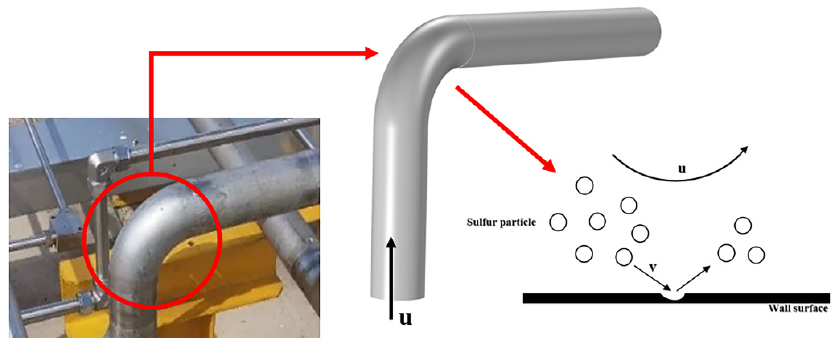
Figure 1. Schematic diagram of the structural model of the research object.